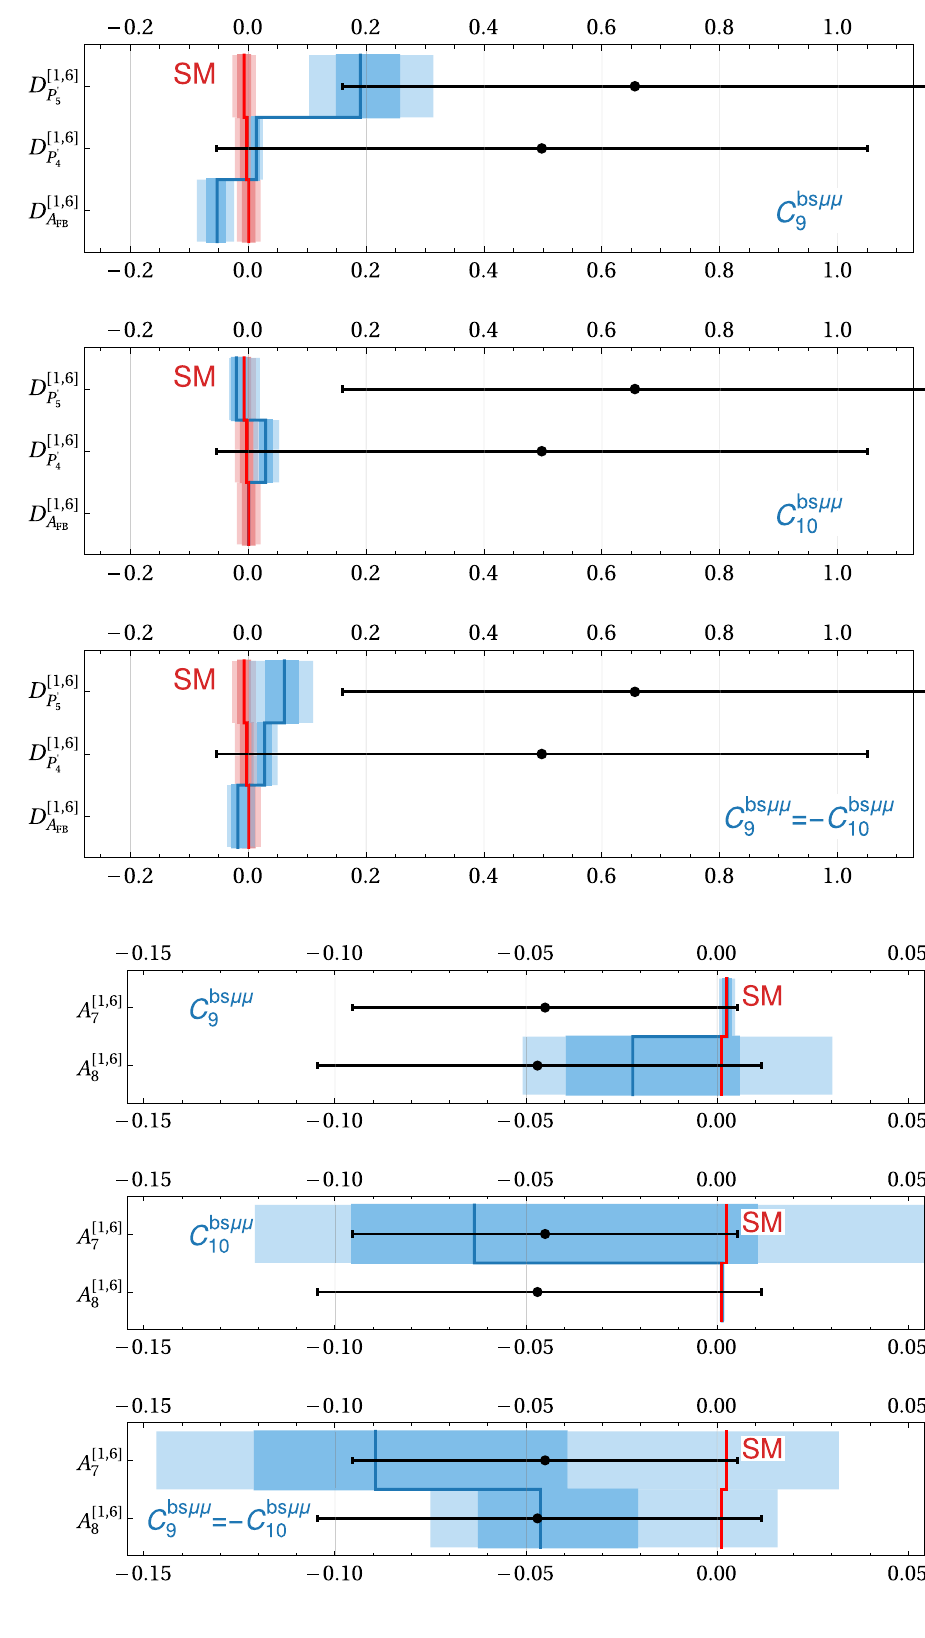
Fig. 9 Predictions for the LFU differences D P (cid:6) , D P (cid:6) , and D A FB 4 5 in three new physics scenarios and the SM. For comparison the current measurements from Belle [30] are shown as well